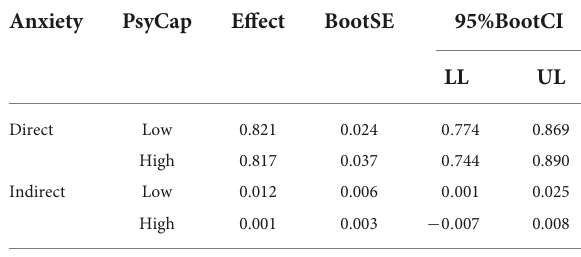
TABLE 5 Bootstrapped conditional direct and indirect